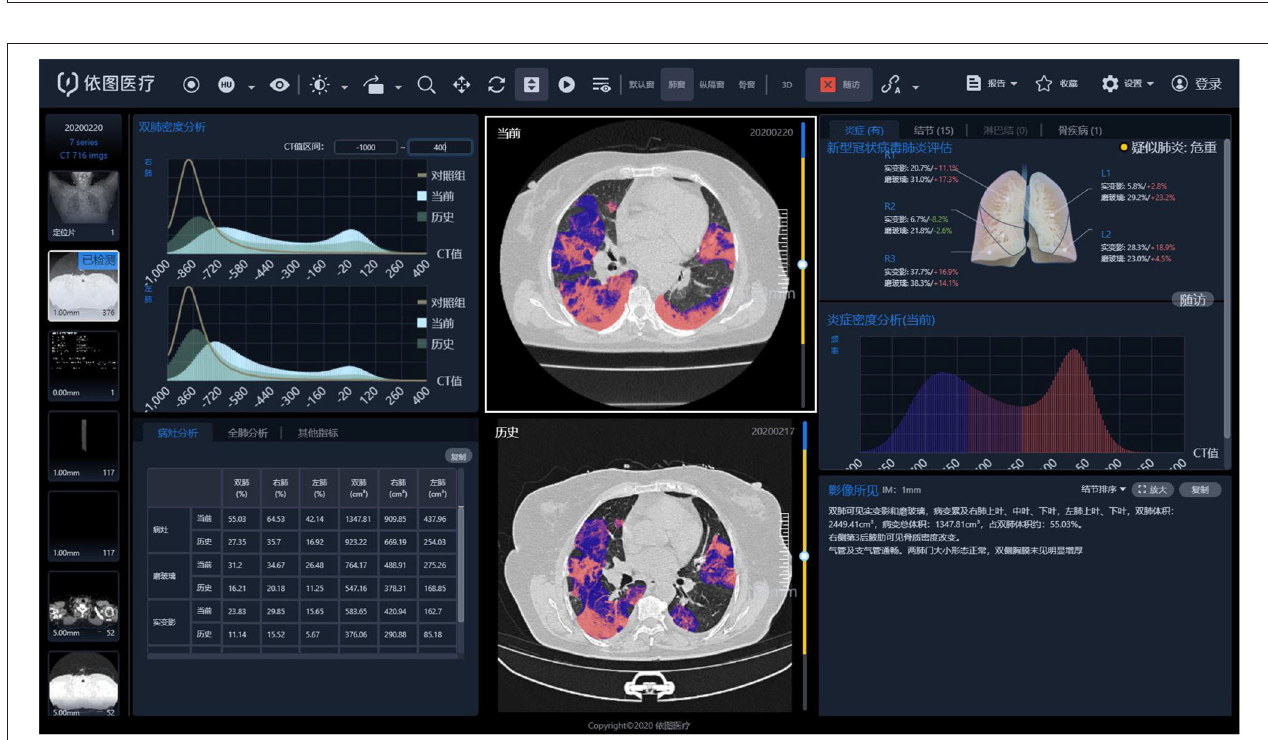
FIGURE 2 | COVID-Lesion Net structure for pneumonia detection and segmentation.